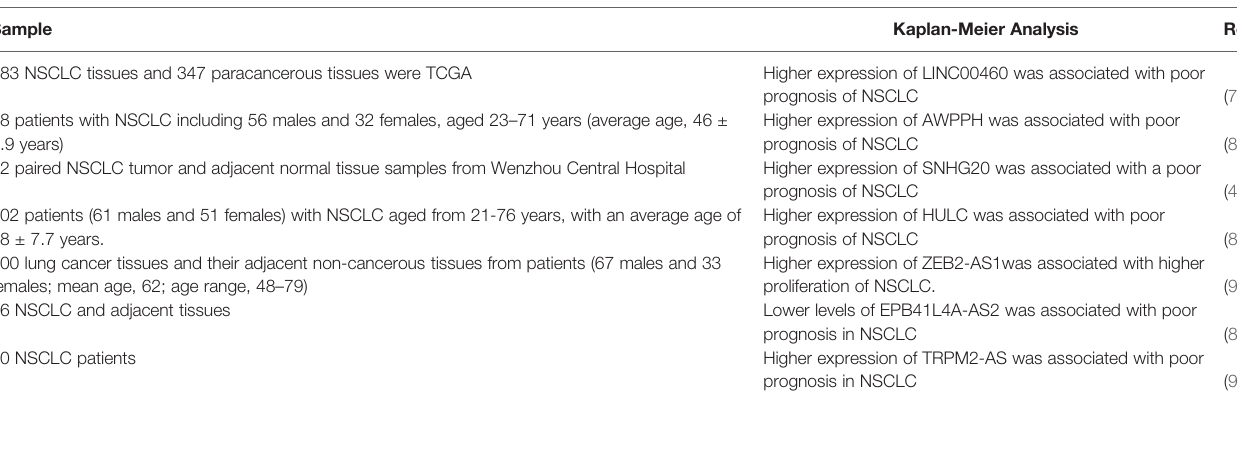
females; mean age, 62; age range, 48 –